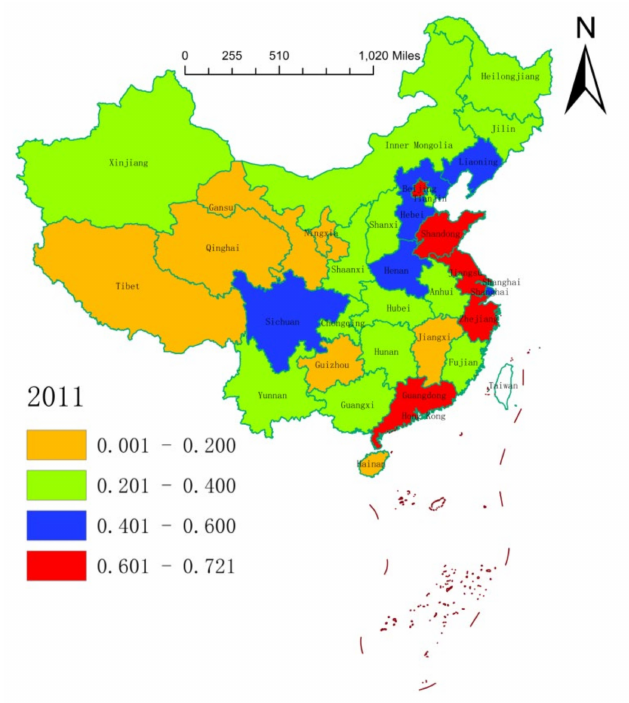
Figure 2. Spatial distribution of health resource agglomeration capacities in China in 2011.